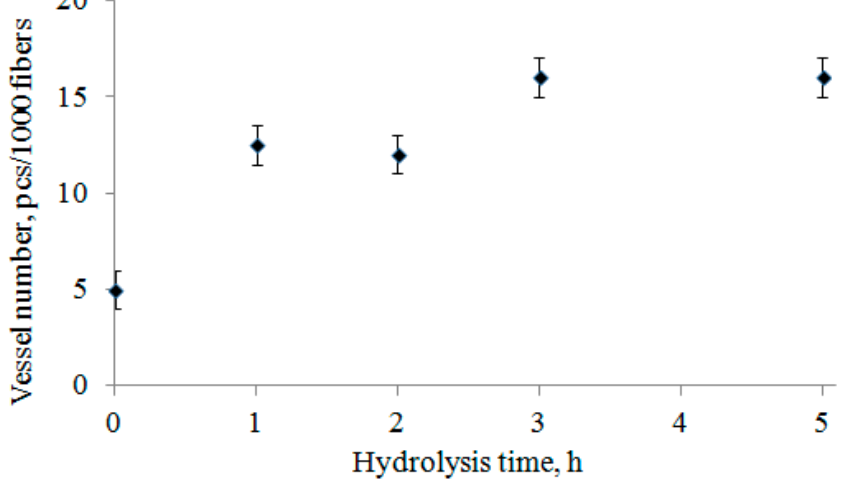
Figure 4. Number of vessels during enzymatic hydrolysis of hardwood pulp.